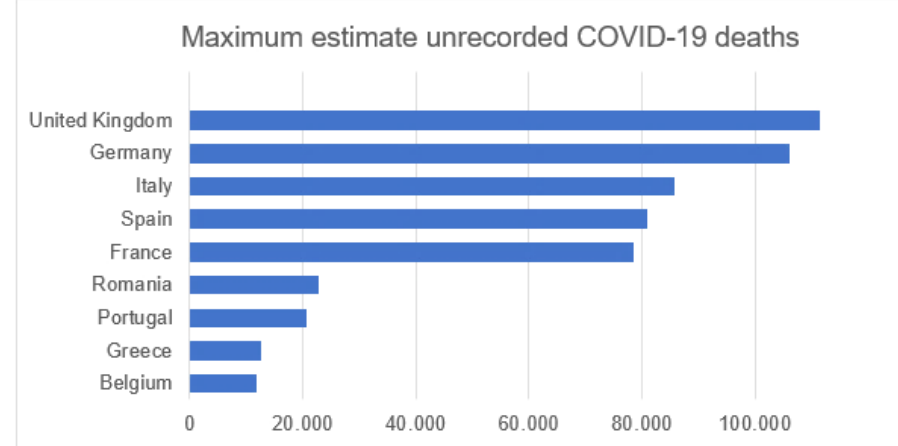
Figure 21. Histogram of calculated mean estimates of unrecorded COVID-19 deaths of the nations surveyed. Negative values are present in cases where the value of officially registered COVID-19 deaths exceeds the mean value of excess deaths estimated for the nation.